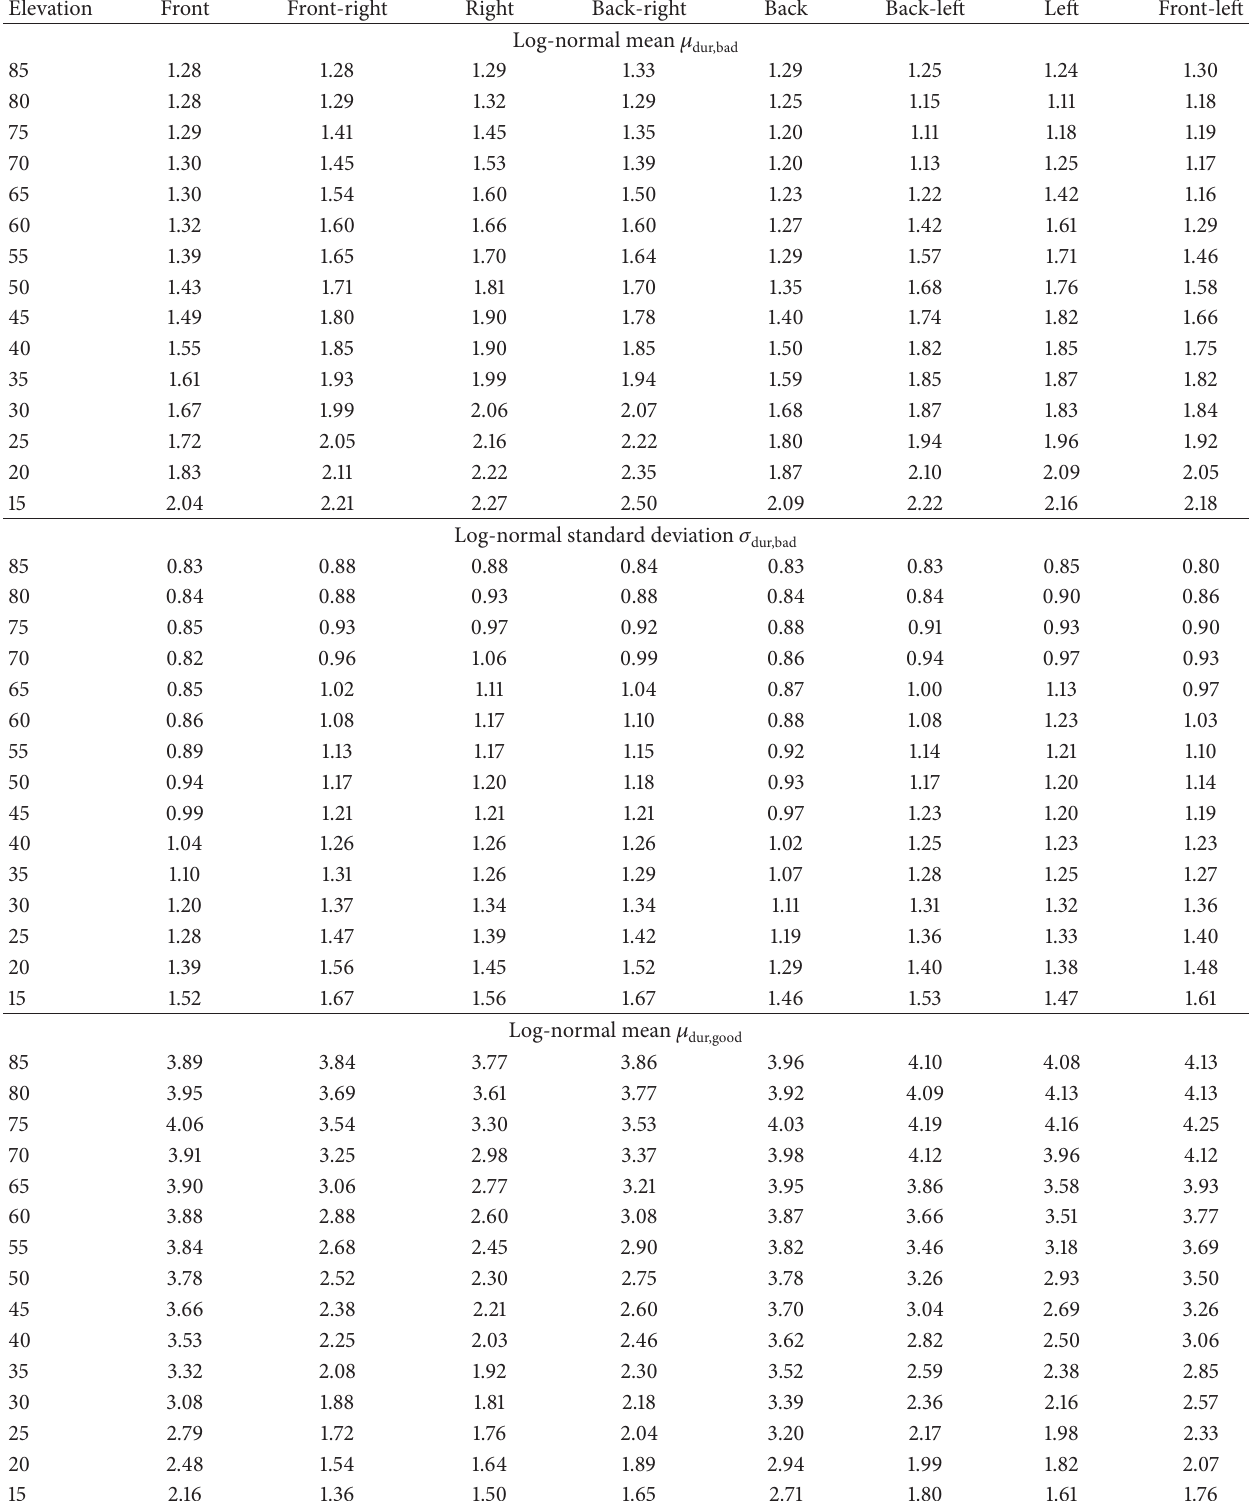
Table 2: Semi-Markov parameters ( good and bad state) for urban environment for variable driving directions and elevations. Elevation Front Front-right Right Back-right Back Back-left Left Front-left Log-normal mean 𝜇 dur,bad